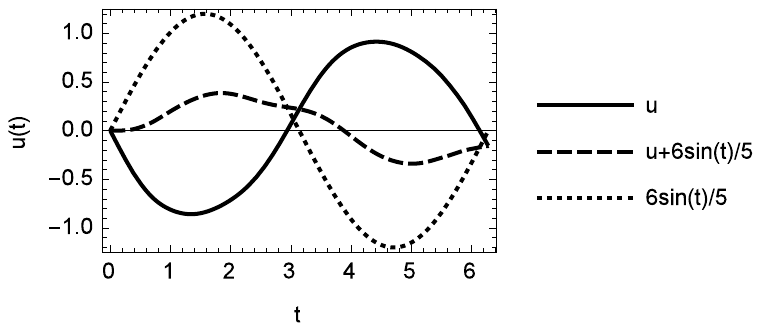
Figure 15. Solution of Levinson’s non-linear Volterra integral